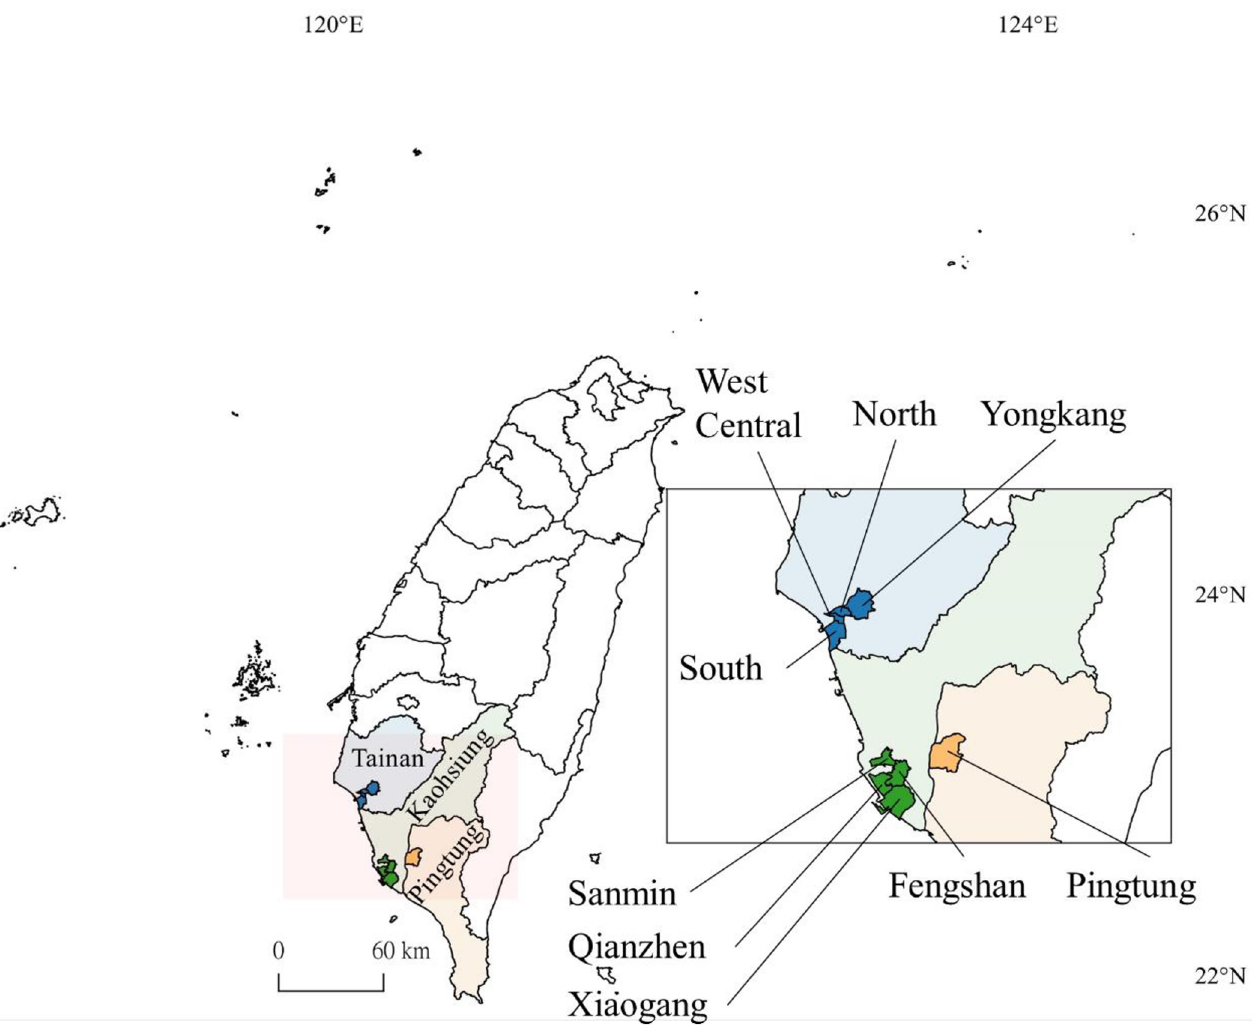
Fig 1. Collection sites of Ae . aegypti . Tainan City (blue color; 4 districts), Kaohsiung City (green color; 4 districts), and Pingtung County (orange color, 1 district), southern Taiwan. The map was created in QGIS 2.18.22, https://qgis.org). The base layer of the map was downloaded from Government Open Data established by National Development Council, Taiwan (https://data.gov.tw/dataset/7442).